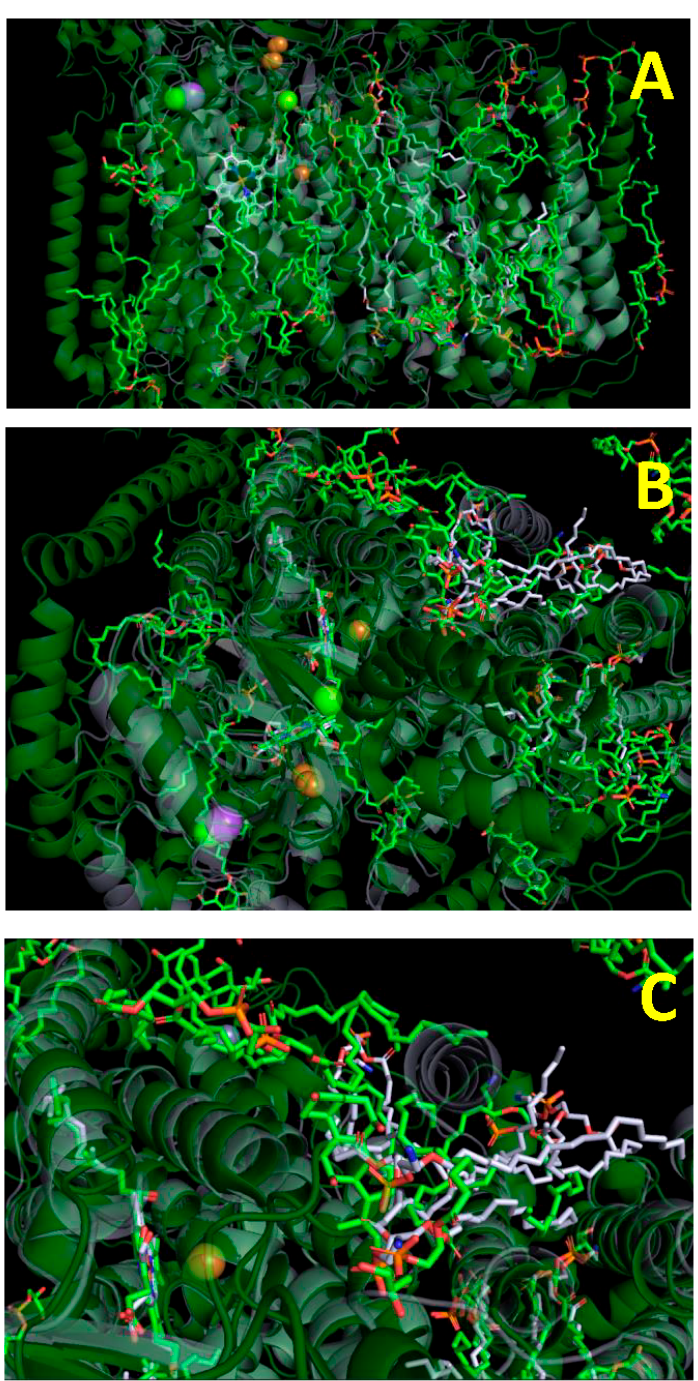
Figure 1. Structure of the type A heme–copper terminal oxidases with tightly bound lipids. 3D structures of dimeric cytochrome c oxidase (CcO) from bovine heart mitochondria (PBD entry 3ASO; green) and CcO from Rhodobacter sphaeroides (PBD entry 1M56; grey) are superimposed. Lipids are shown by sticks in the corresponding colors, with oxygen (red), nitrogen (blue) and phosphorus (orange) highlighted. ( A ) Side view, matrix is at the bottom. Near the outer membrane’s surface, mutually perpendicular planes of hemes a and a 3 are seen, as well as the copper centers (binuclear Cu A and mononuclear Cu B , brown spheres). ( B ) View from the outer surface of the membrane. ( C ) Enlarged part of ( B ). Subunit III is located on the right side of the